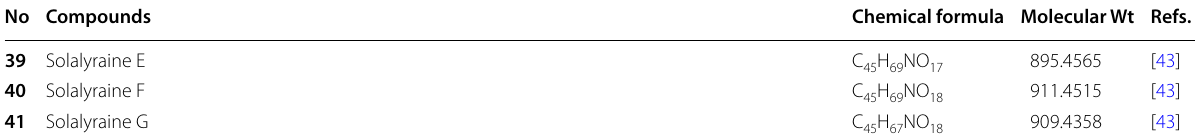
Fig. 6 Representative six common steroidal